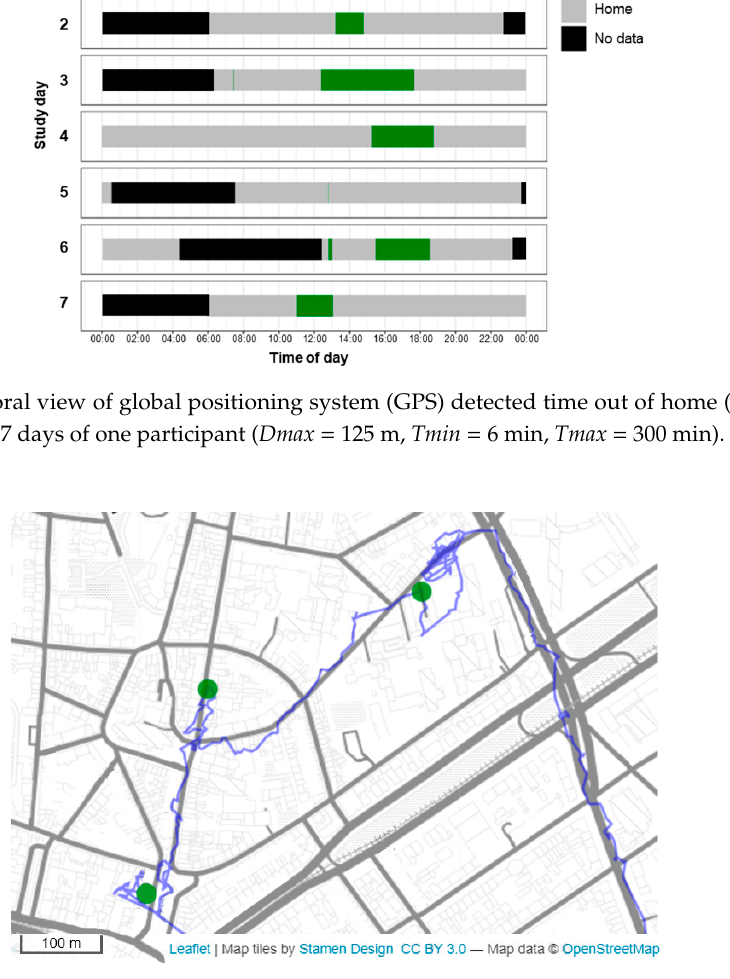
Figure 3. Some detected activity locations (green dots) for one study day of one user ( Dmax = 125 m, Tmin = 6 min, Tmax = 300 min). This illustration also shows the typical positional data quality of the raw, unprocessed GPS